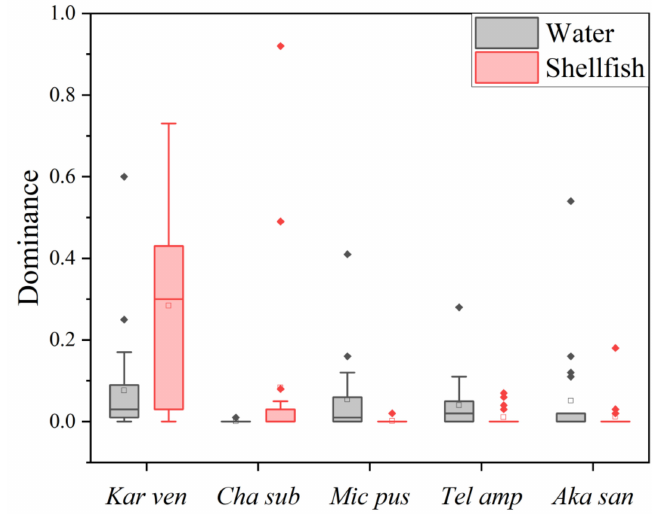
Figure 2. The top five dominant species and dominance in the stomachs of R. philippinarum in the water of the Yalu River Estuary. Vertical bars are the mean ± SE. Kar van : Karlodinium veneficum ; Cha sub : Chattonella subsalsa ; Mic pus : Micromonas pusilla ; Tel amp : Teleaulax amphioxeia ; Aka san : Akashiwo sanguinea